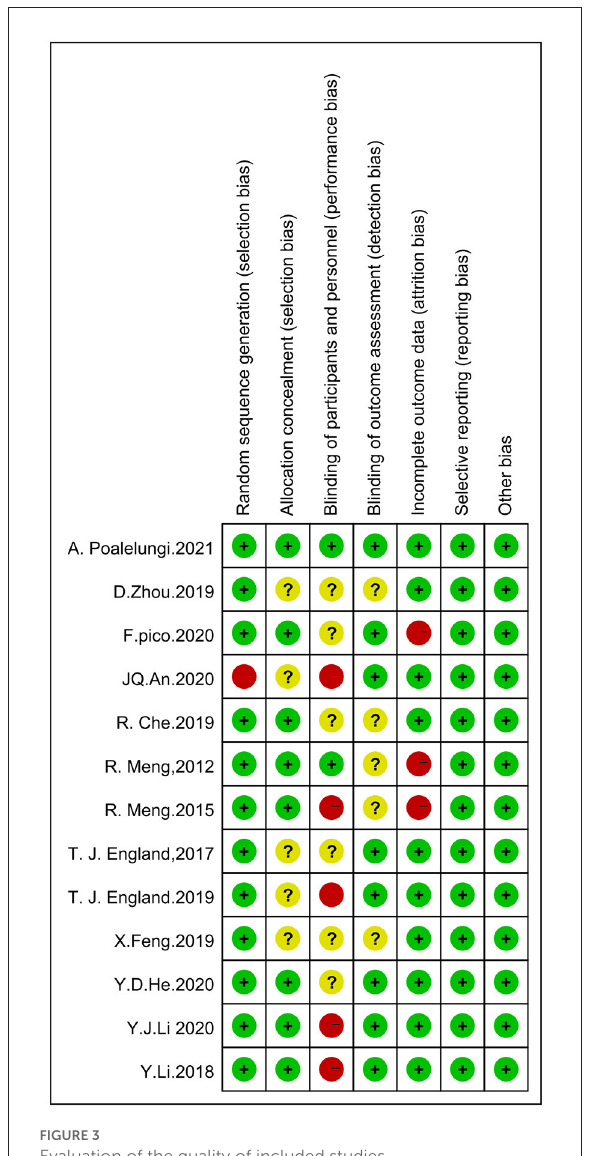
FIGURE3 Evaluation of the quality of included studies.